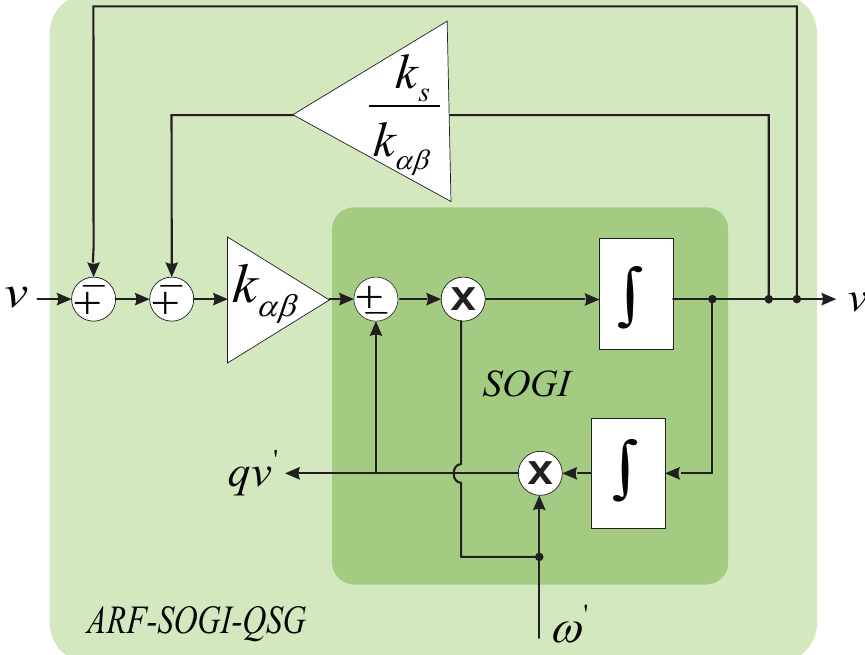
Figure 3. Block diagram representation of the